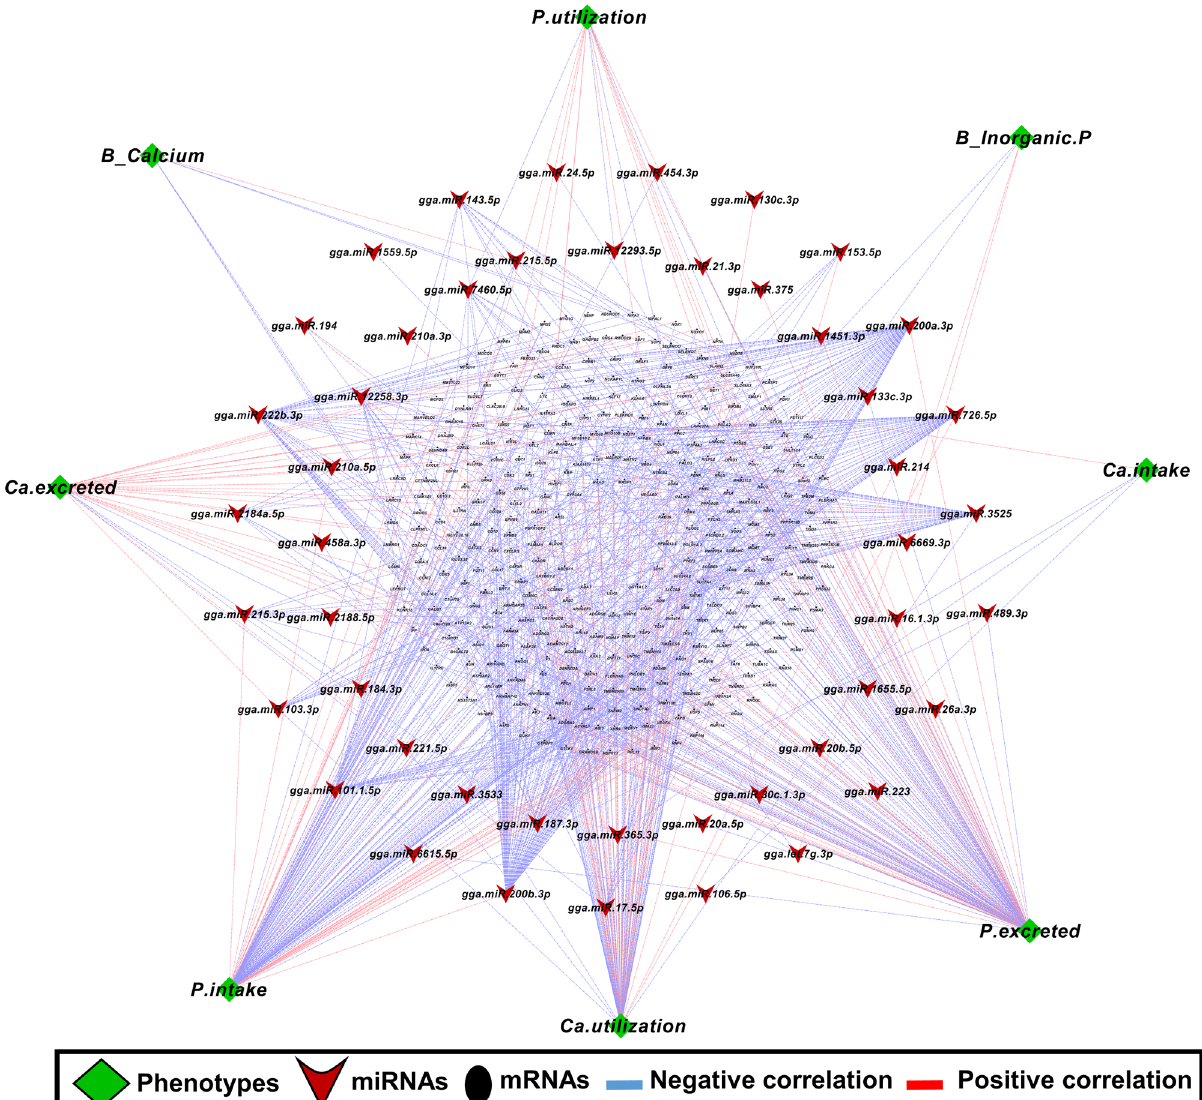
Figure 10. Correlation network analysis of known miRNAs-mRNA from different diet and phenotype of LSL strain. Correlation network was generated using MetScape (version 3.1.3) plugin in Cytoscape (version 3.6.1) environment. The mRNAs with negative correlation with miRNAs were considered significant. Green color diamond shape indicates phenotype data within LSL strain. Red V-shape indicates the deferentially expressed known miRNAs from diet groups within in LSL strain and black ellipse shape indicates the mRNA. Blue line indicates the correlation between Phenotype-miRNA and